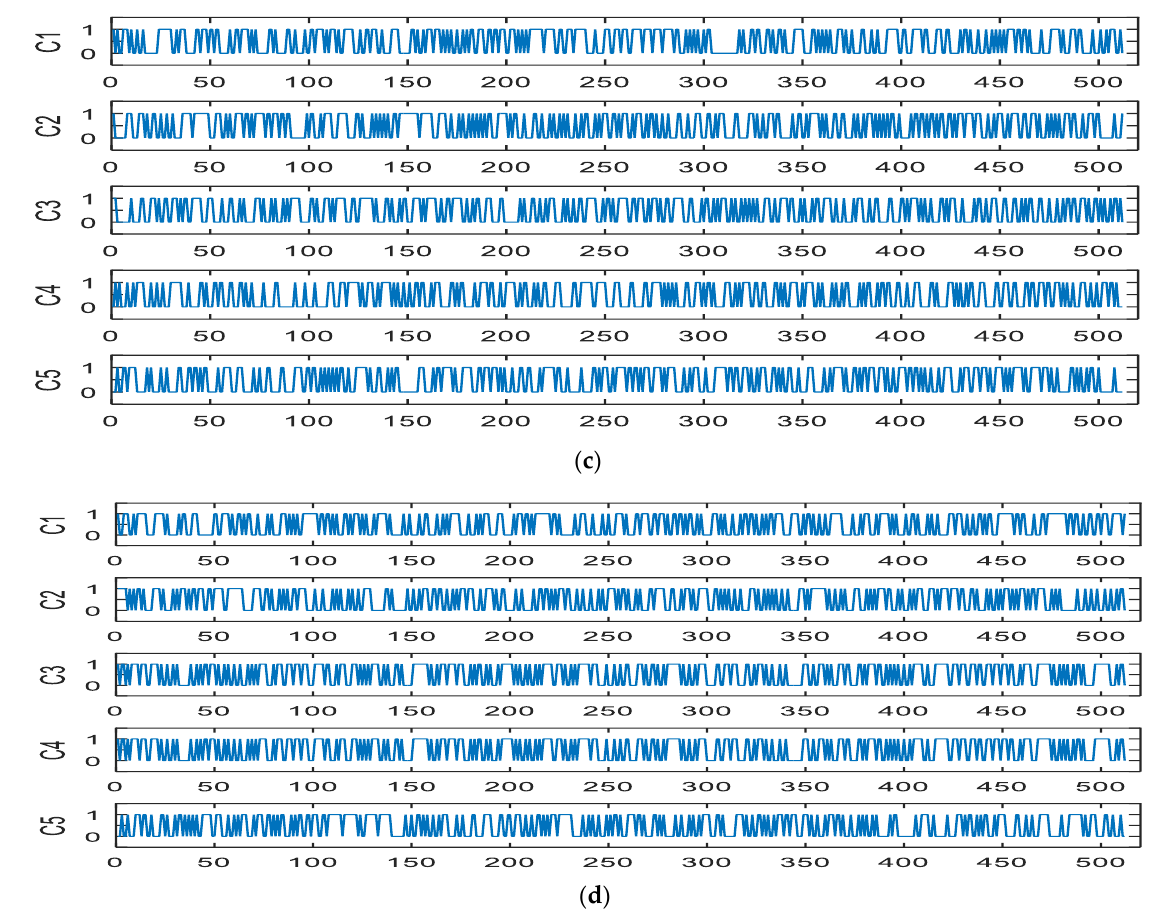
Figure 11. Hash values under different conditions: ( a ) first structure; ( b ) second structure; ( c ) third structure; ( d ) fourth structure. Table 4. Hash values of first structure.